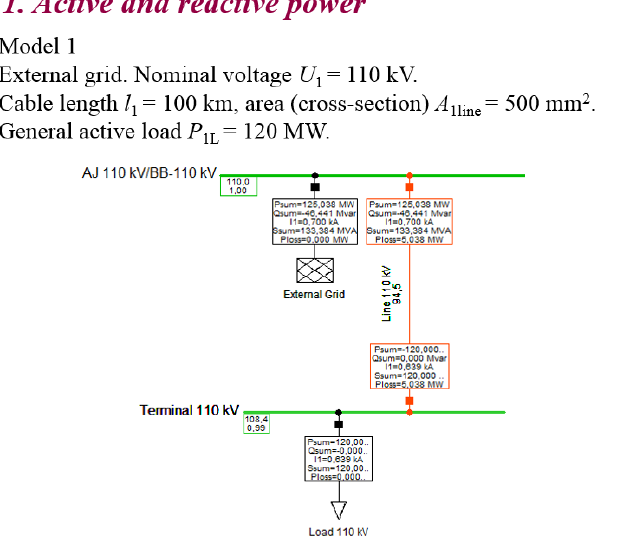
Fig. 1. A part of a slide presenting an electrical power line.